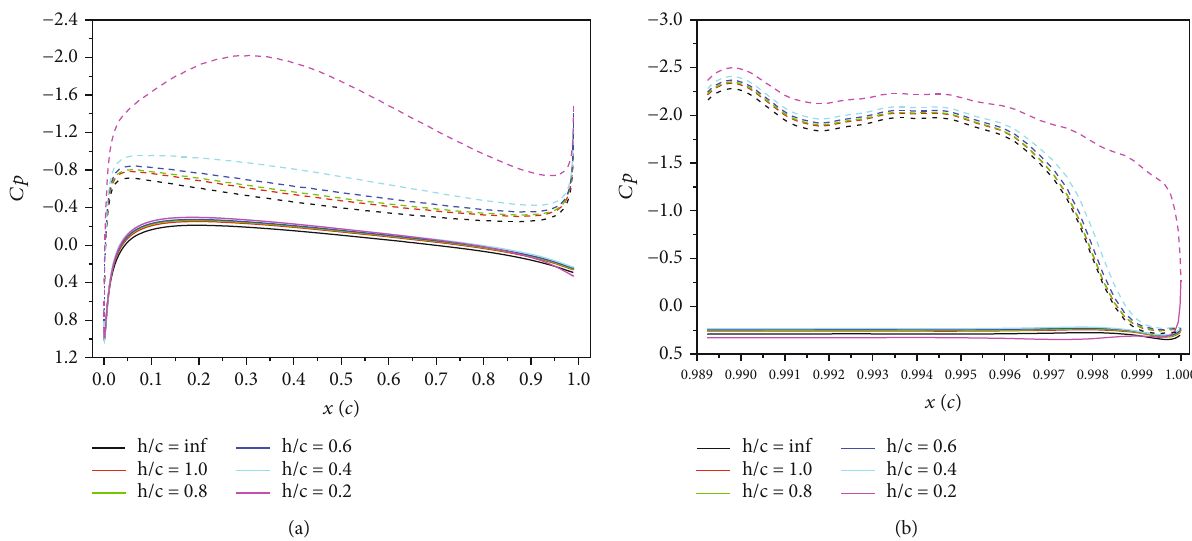
= − 0 : 014 at α = 0 ° : (a) pressure coe ffi cient of the main airfoil; (b) μ